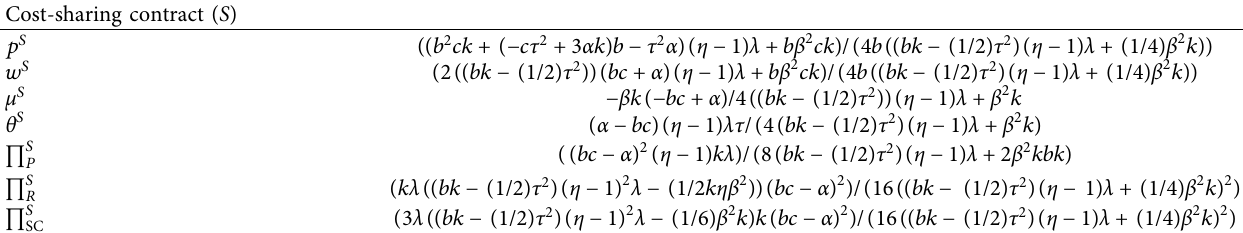
Table 3: Equilibrium decisions and profitability under the cost-sharing